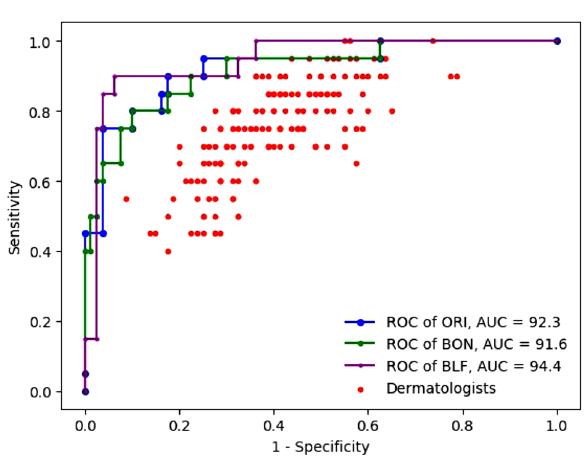
Figure 9. The receiver operating characteristic curves of ORI, BON, and BLF over the MClass-D